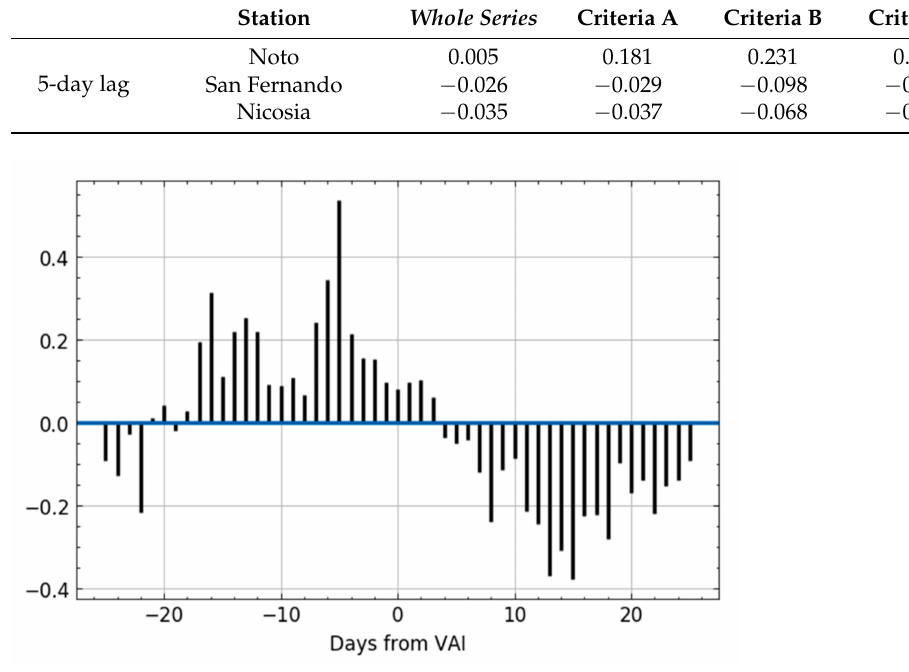
Figure 14. Normalised cross-correlation between VRP and TEC mean values for Criteria C, IGS Noto. The lag with maximum correlation value is equal to 5